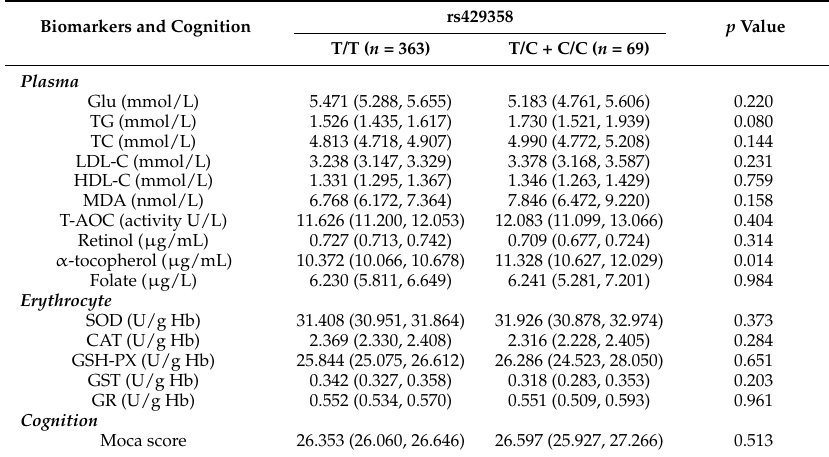
Table 2. Plasma, erythrocyte parameters and cognition according to APOE rs429358.